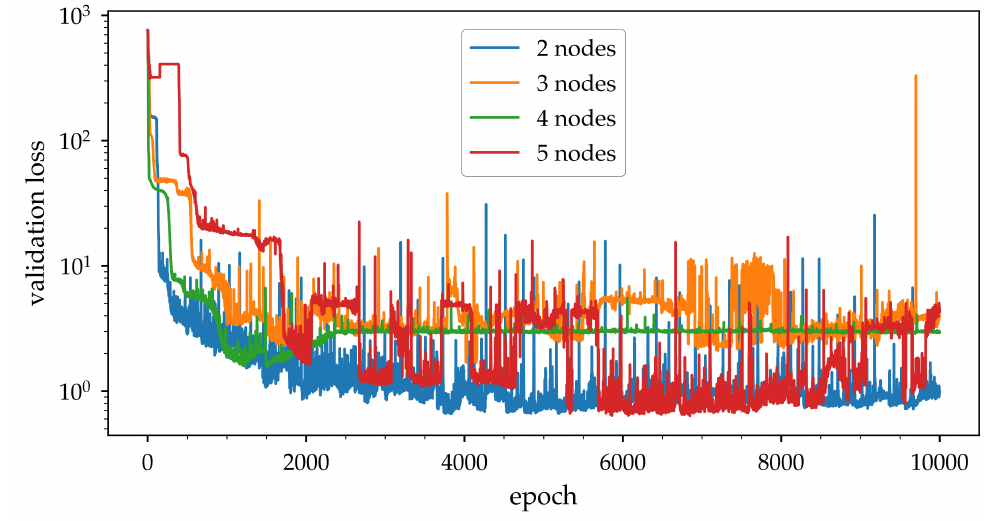
Figure 13. Loss as a function of epoch for the validation set when training on 5 weeks of